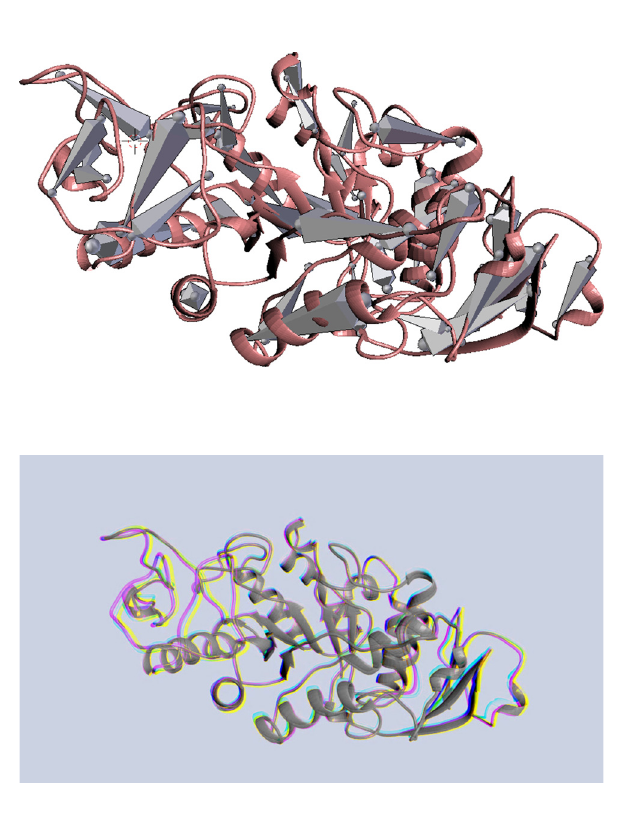
Figure 5: A snapshot of the animation display for α -amylase (pdb 1AMY). Three conformations at different time frames, depicted in yellow, cyan, and magenta, are simply superimposed to demonstrate the movement. Overlapped regions then become